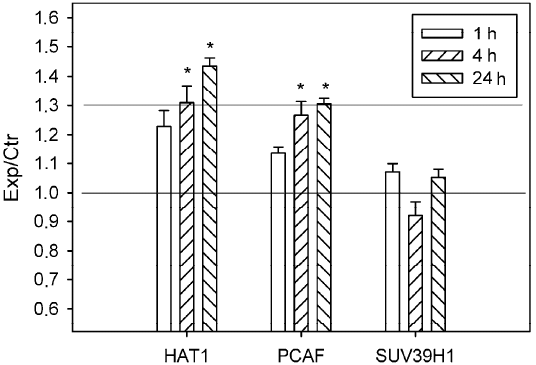
Figure 7. The ratios of levels of histone acetyltransferases HAT1 and PSAF, and histone-lysine N-methyltransferase SUV39H1 in the ischemic penumbra 1, 4 or 24 h after photothrombotic stroke in the rat cerebral cortex (Exp) to those in the untreated contralateral cortex of the same animals (Ctr). The antibody microarray data. n = 16 (4 animals × 4 values in each experiment). Mean ± SD. * p < 0.05.